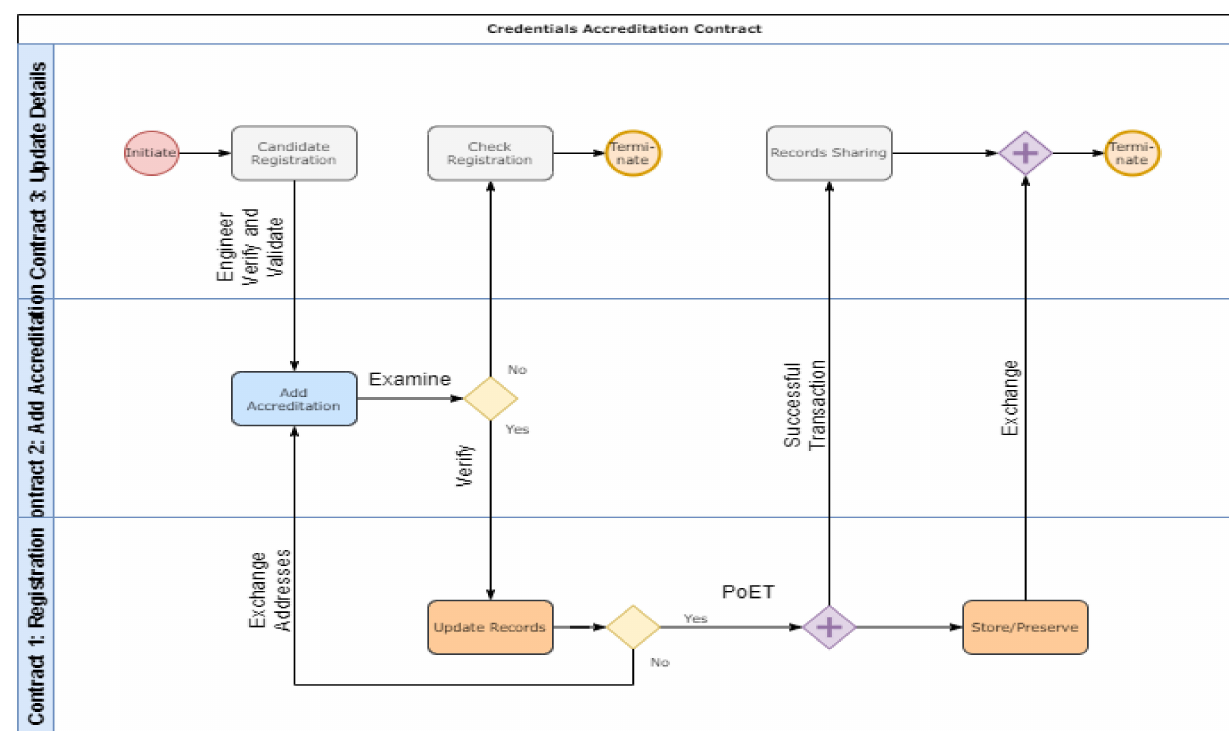
Figure 4. Events of education-accreditation node transactions.